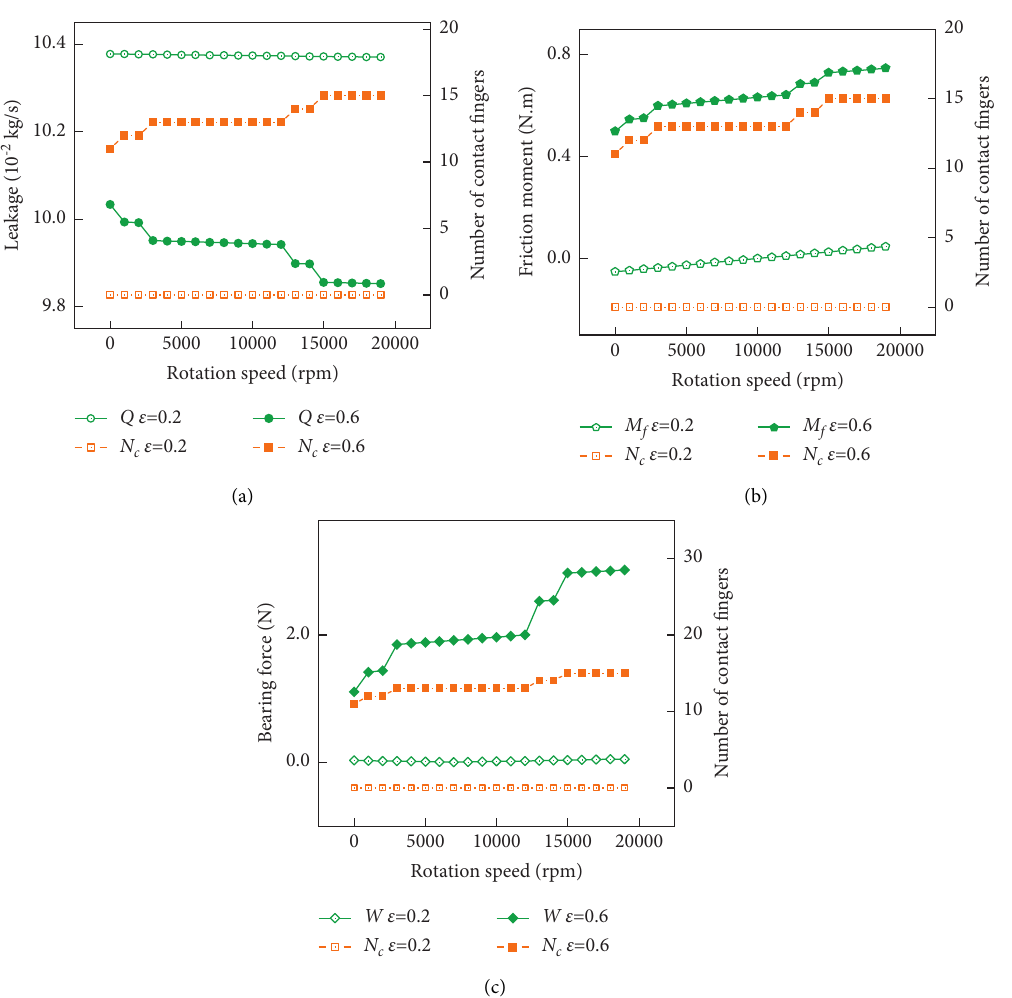
Figure 12: Effect of rotation speed. (a) Leakage for various rotation speeds. (b) Friction moment for various rotation speeds. (c) Bearing force for various rotation